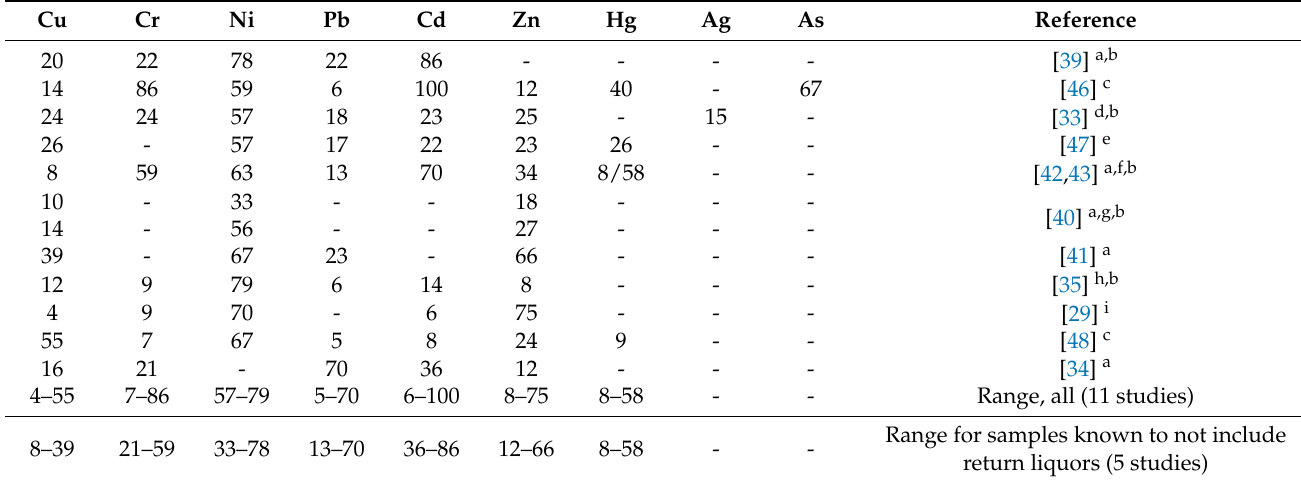
Table 3. Fraction of dissolved heavy metals (%, concentration of dissolved heavy metals in relation to total heavy metal concentrations) in influent